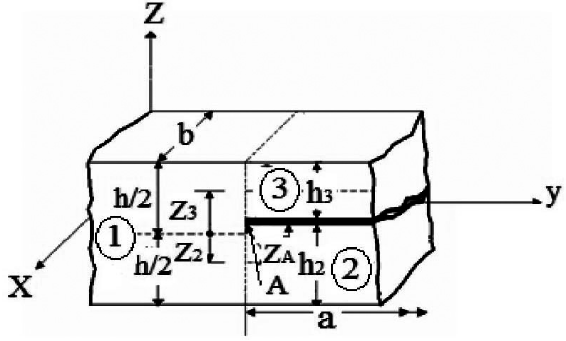
Fig. 2. Plate elements at a delamination crack tip